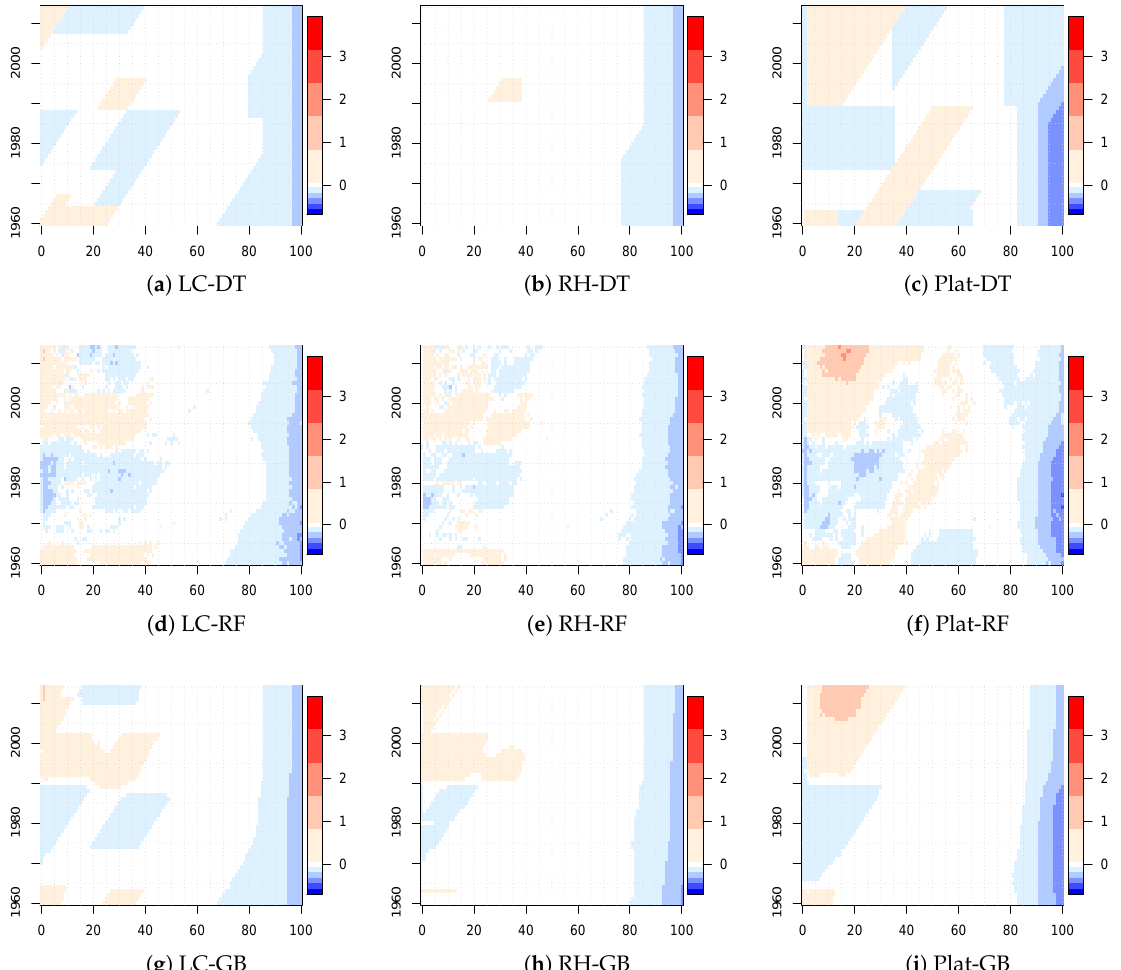
Figure A3. Values of ∆ m mdl,ML x . Italian female population. Ages 0–100 and years